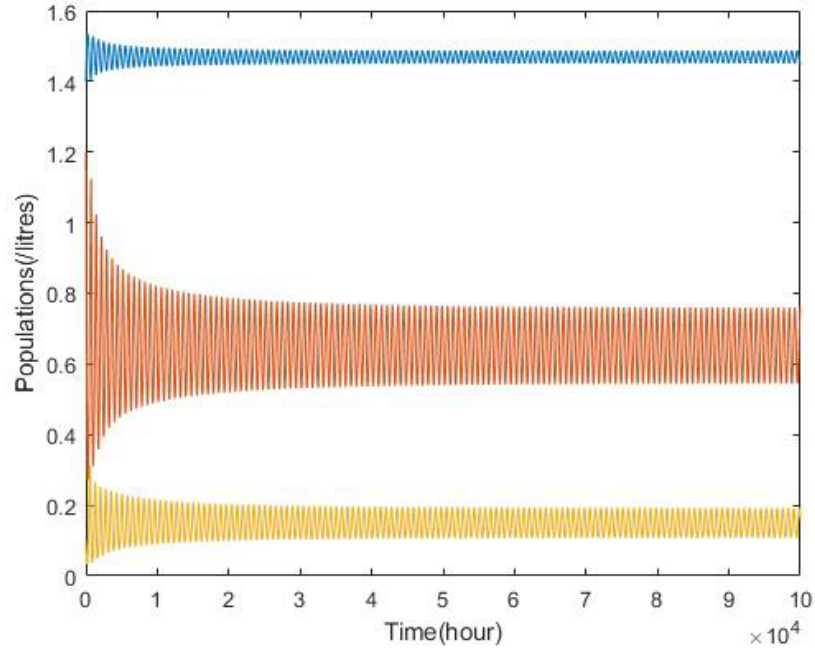
Figure 29. Simulation results of System (16) for τ = τ −